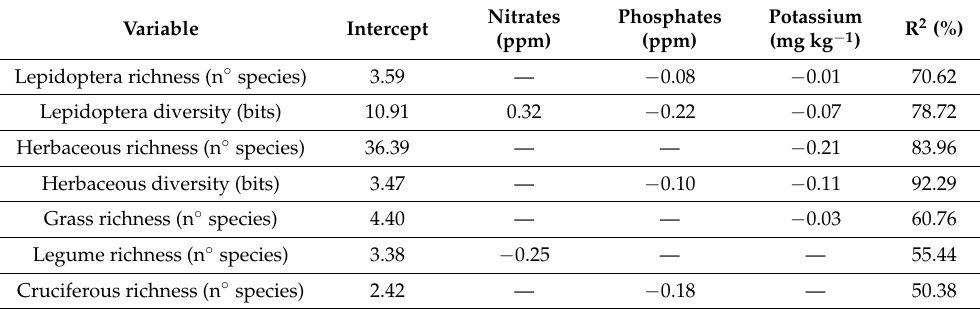
Table 2. Regression analysis results for each biological variable, specifying their units. The intercepts, along with the coefficients for each significant independent variable in the model including their units (in case of nonsignificant variables, no value is specified), and the R 2 values (%) are specified.